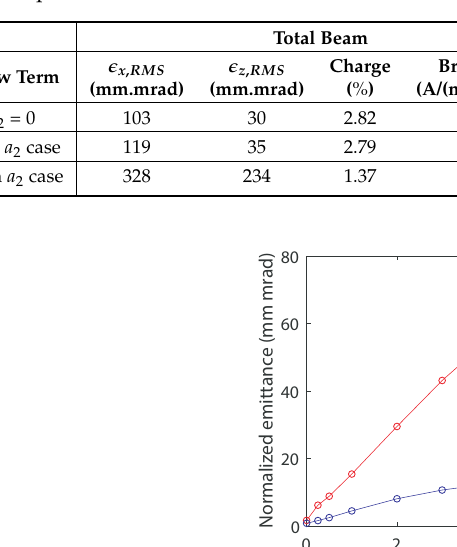
Table 5. Horizontal and vertical normalized emittance and charge percentage arriving of the electron beam at the undulator center for a 2 = 0, low and high a 2 (Table 2) cases. Simulation using the low = 2 mrad, divergence initial beam distribution (Figure 2a), 176 MeV “monochromatic” beam with σ (cid:48) z , i = 3.12, initial charge 100 pC, mrad (cid:101) σ (cid:48) z , i , (cid:101) x , i = 0.2 mm.mrad, transported with the “slit-undulator” x , i optics (slit closed to 3.2 mm corresponding to a slice of 176 ± 7 MeV). Each point averaged over 5 repetitions of the simulation.